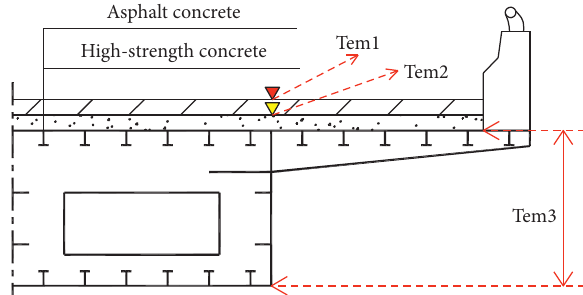
Figure 4: Positions of the